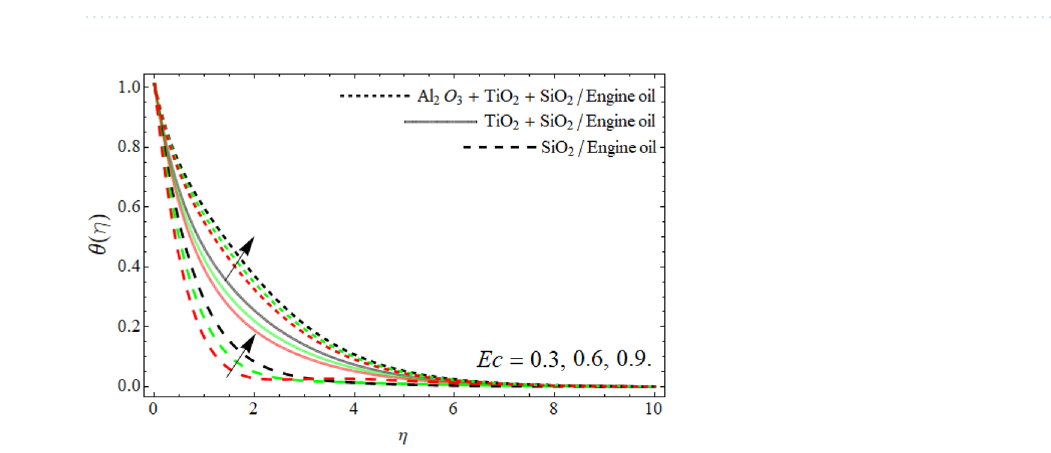
Figure 9. The energy θ(η) outlines versus H t .